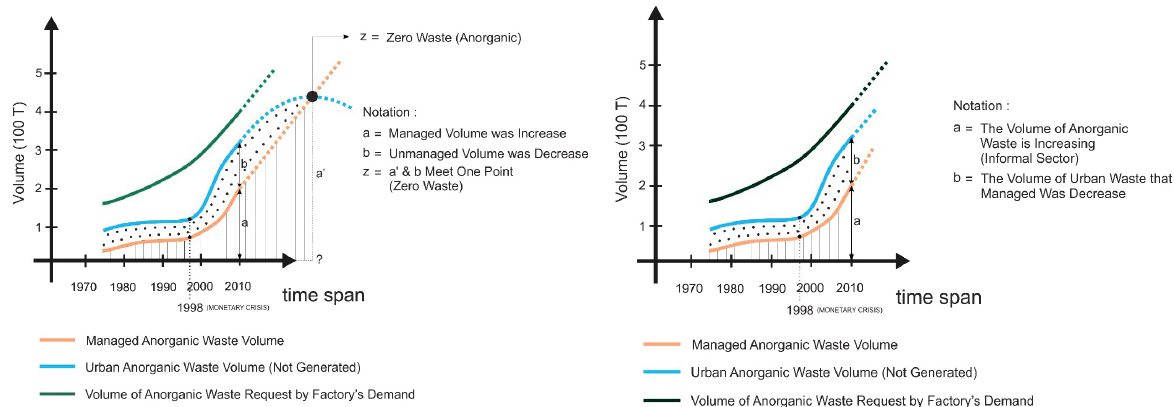
Fig. 3. The Informal Sector of Managed Anorganic Waste was increase